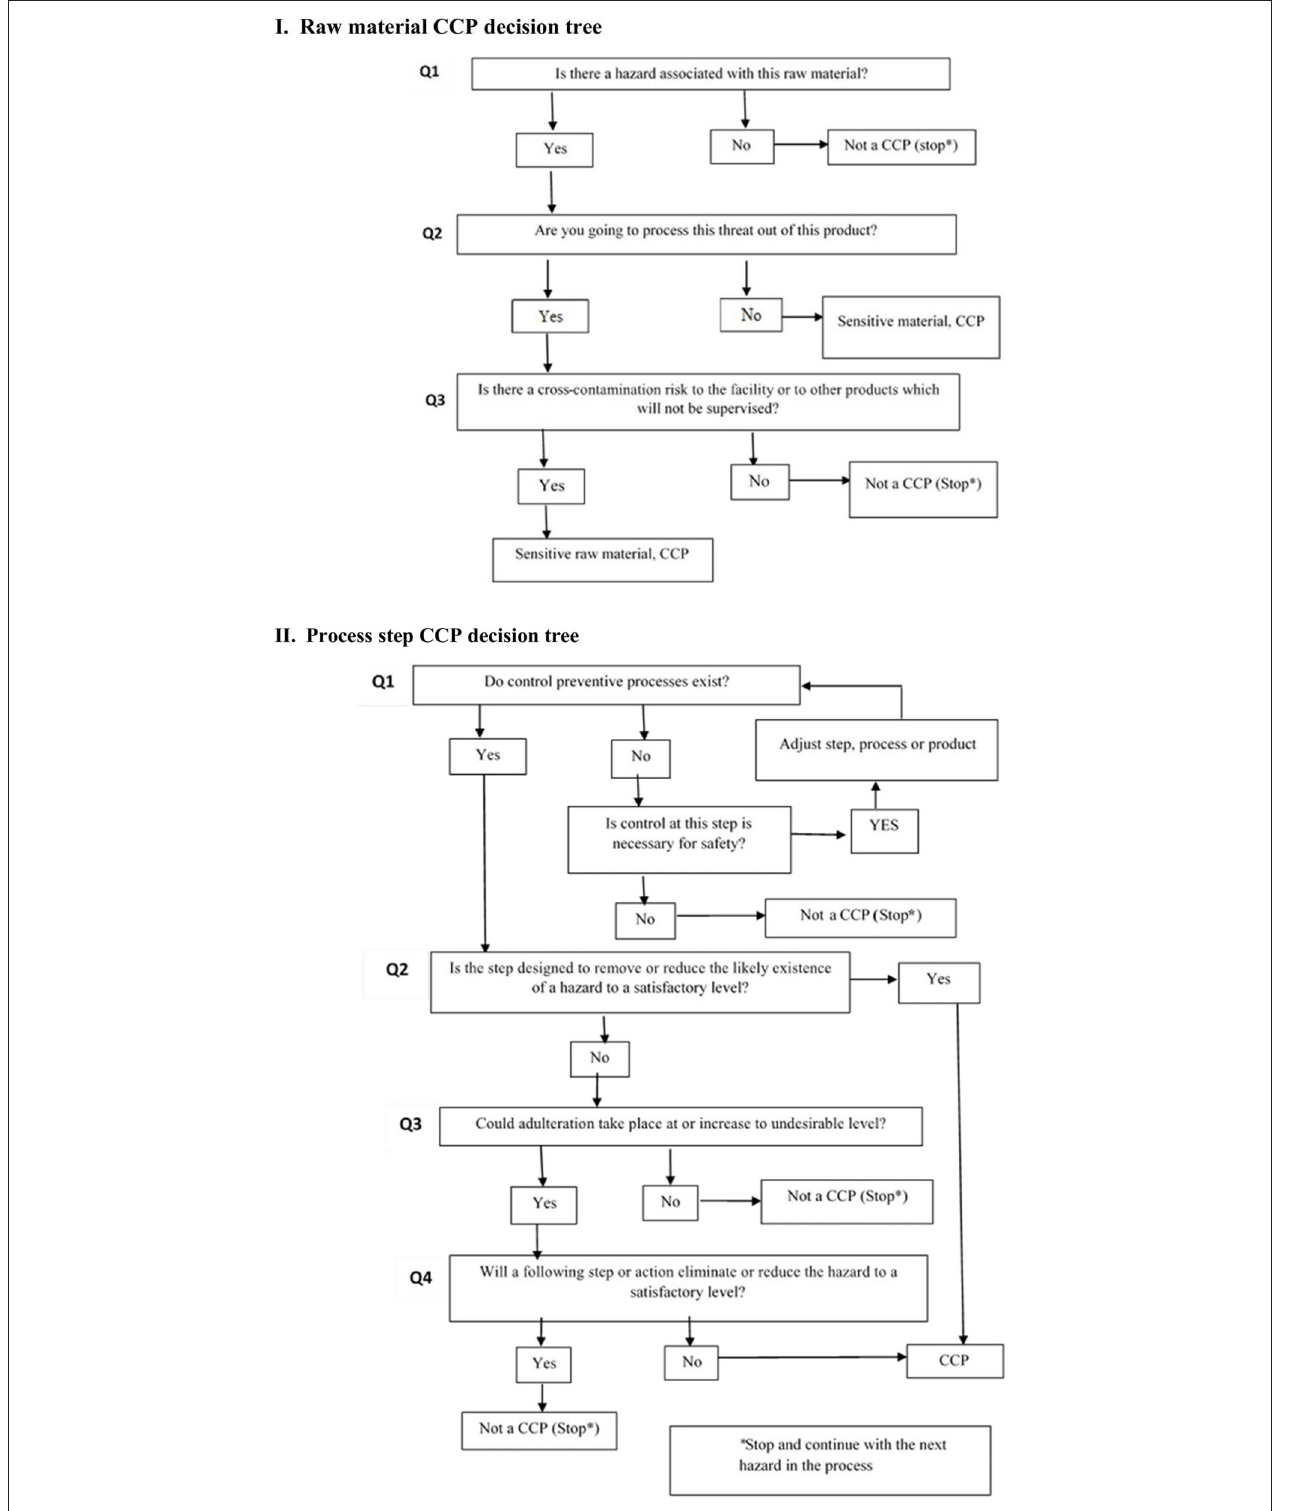
FIGURE 2 | CCP process decision tree (I – Raw material CCP decision tree; II – Process step CCP decision tree).